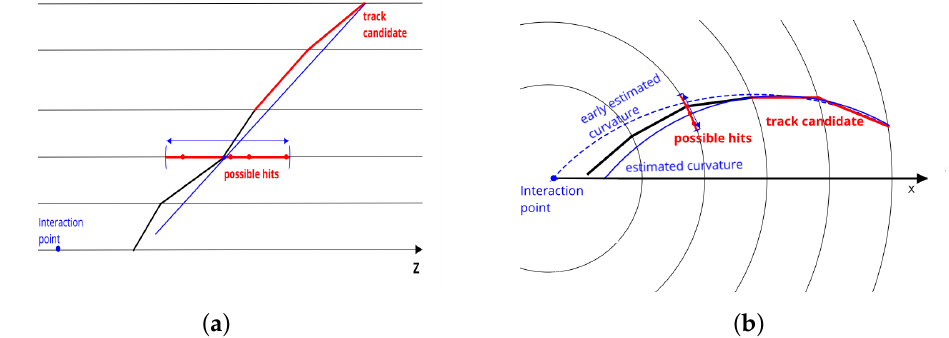
Figure 4. ( a ) Longitudinal projection scheme for a secondary track. ( b ) Transverse projection scheme for a secondary